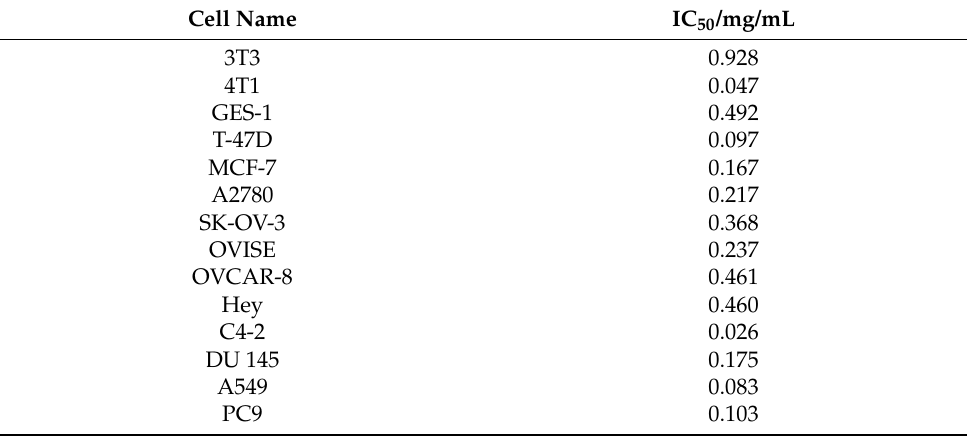
Table 1. Effects of PPO on cell viability of 3T3 1 , 4T1 2 , GES-1 3 , T-47D 4 , MCF-7 5 , A2780 6 , SK-OV-3 7